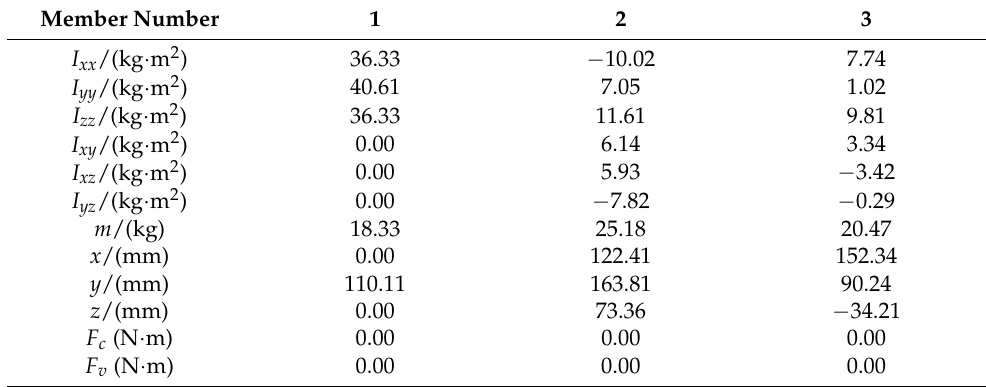
Table 2. Actual kinetic